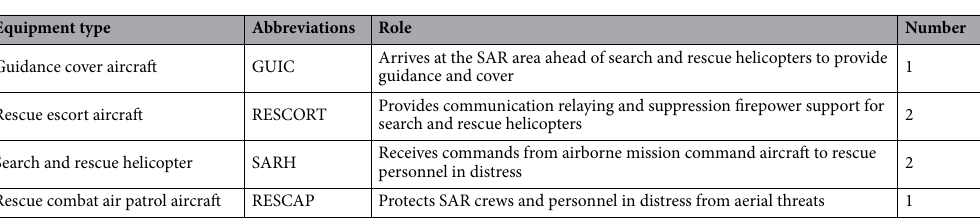
Table 2. Role and quantity of the aviation